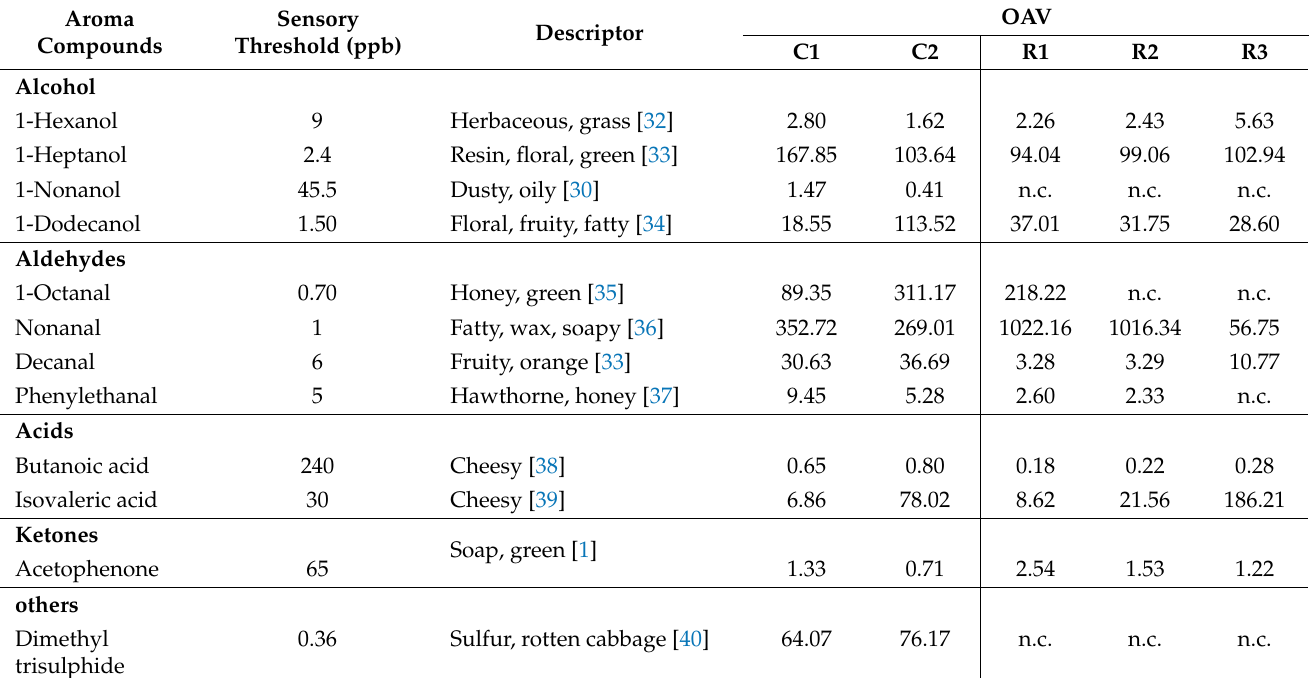
Table 5. Sensory threshold, descriptors, and odor activity value (OAV) of volatile compounds in different anchovy